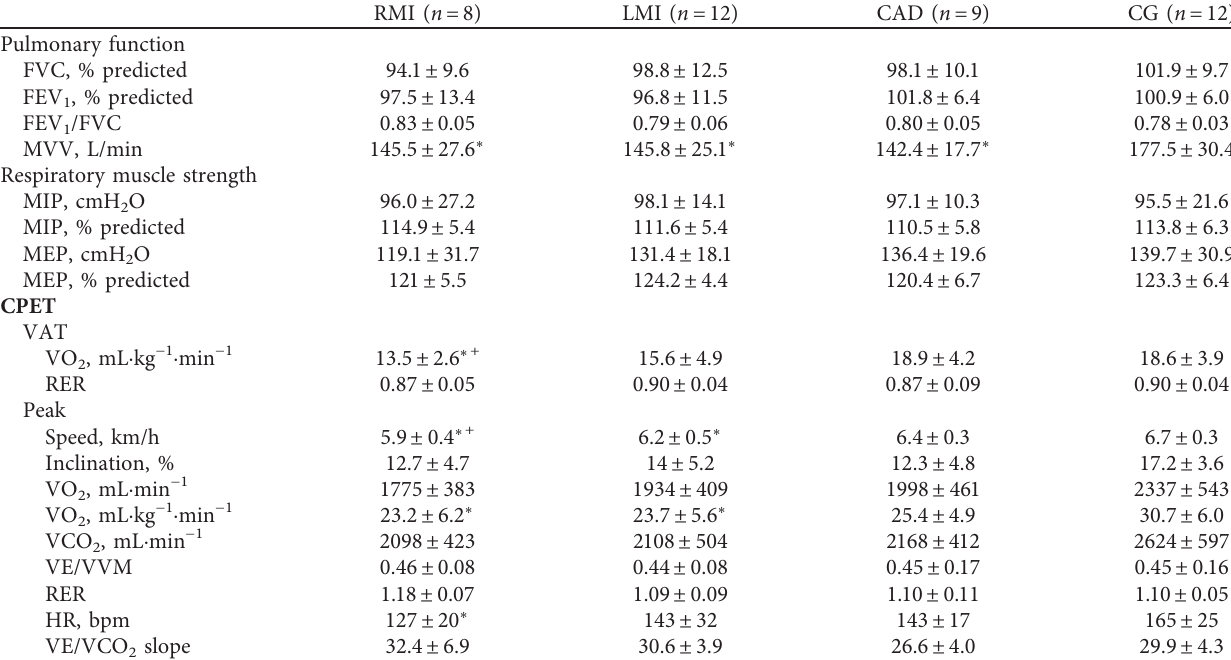
Table 3: Resting pulmonary function, respiratory muscle strength, and CPET variables of all groups.